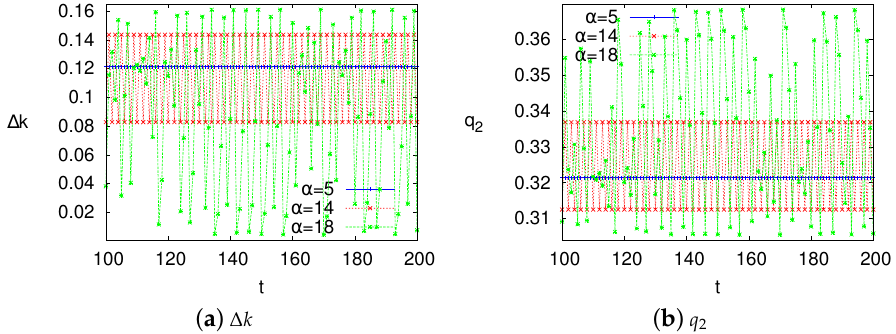
Figure 4. Time series of decisions under different system